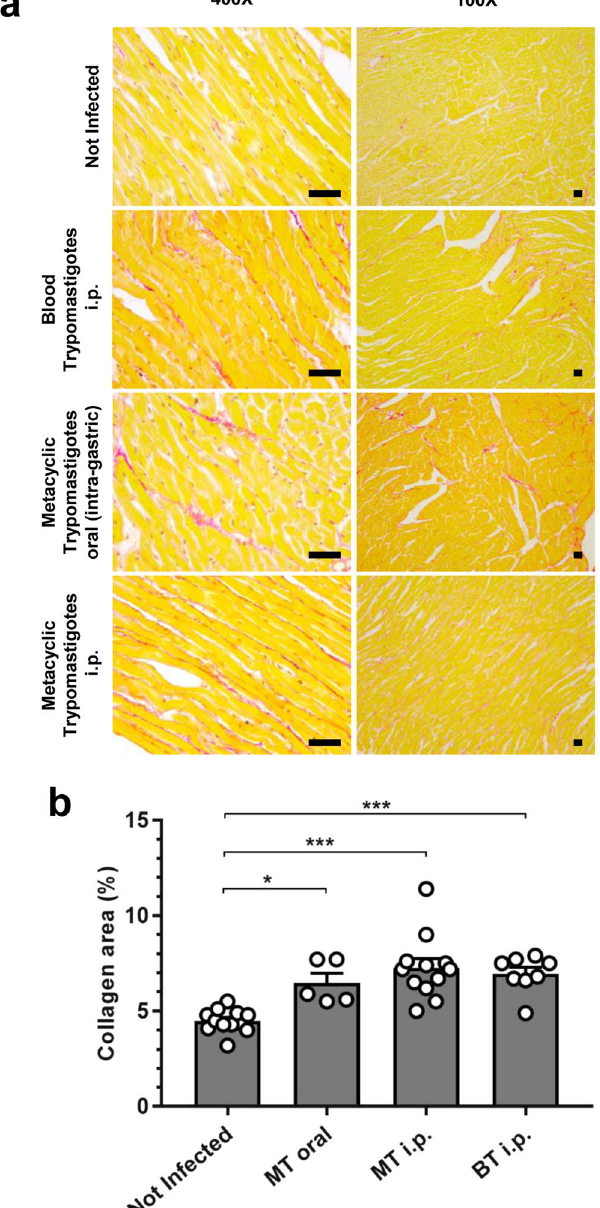
Figure 5. Cardiac fibrosis in mice chronically infected with T. cruzi after oral transmission. ( a ) Representative myocardial sections stained with picro-sirius red, magnification 400X and 100X , scale bar = 100 µ m. ( b ) Quantification of collagen content (% red area in stained sections) as a marker of cardiac fibrosis severity. Data are the means ± SEM, pooled from three experiments. Not infected n = 12, MT oral n = 5, MT i.p. n = 12, BT i.p. n = 8. Asterisks indicate p -values for comparisons with the not infected control group in a one-way ANOVA test ( * p < 0.05; *** p <